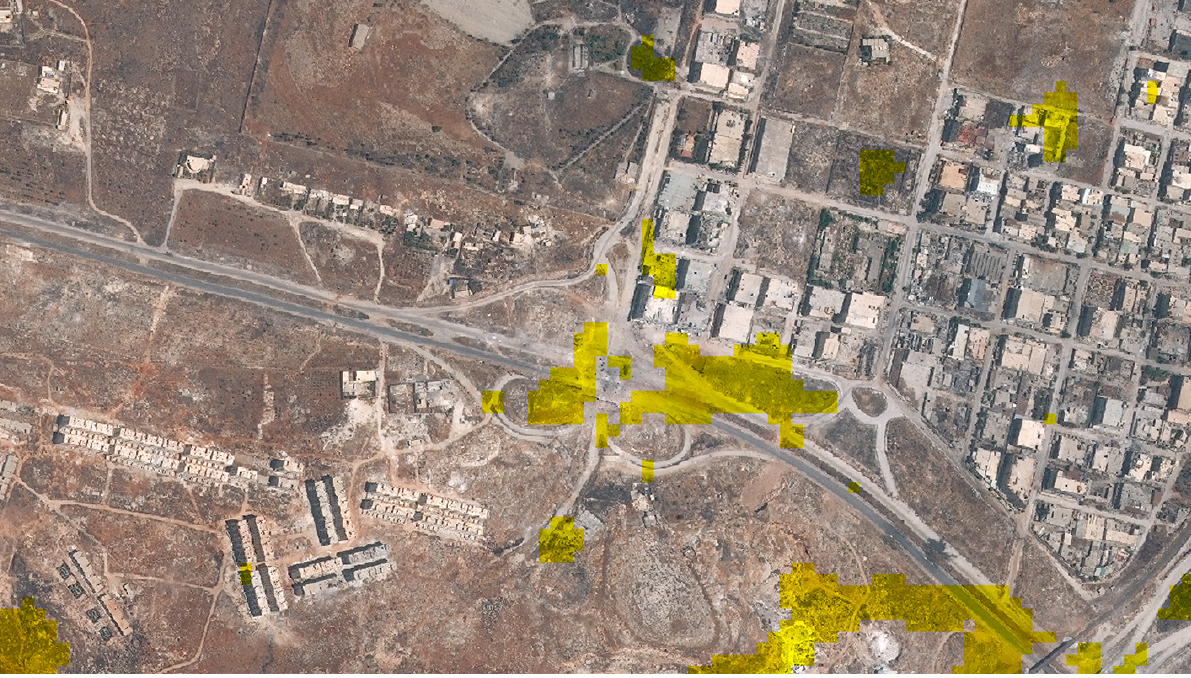
Figure 6. High resolution satellite image from June 11, 2016 (one day after the second Landsat image was taken) which shows major damage to Castello Road overpass as well as buildings in the surrounding area. Satellite images from World View II © Digital Globe 2015 & 2016. Significant pixel change detection algorithm developed by Jamon Van Den